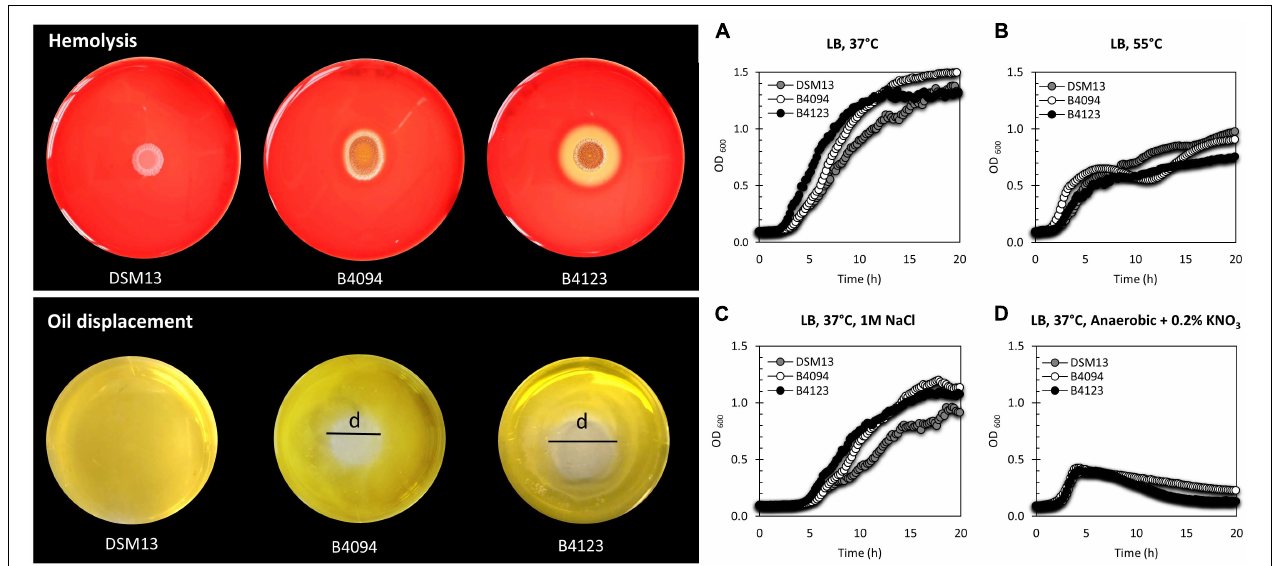
FIGURE 2 | Hemolysis, oil displacement, and representative growth data for the three selected strains, B4094, B4123, and DSM13 T . (Top left) DSM13 T , B4094, and B4123 growth on Columbia blood agar showing hemolytic activity. The clearing zone on the blood agar indicates results from lysis of erythrocytes, indicative of the presence of the biosurfactant lichenysin. (Bottom left) The oil displacement activity of DSM13 T , B4094, and B4123. The displacement zone (d) shows the oil-repelling movement away from water, indicative of the presence of a surfactant. (Right) Aerobic and anaerobic growth data for DSM13 T (gray), B4094 (white), and B4123 (black) in LB medium. (A) Growth in LB at 37 ◦ C; (B) Growth in LB at 55 ◦ C; (C) Growth in LB + 1M NaCl at 37 ◦ C; (D) Anaerobic growth in LB + 0.2% KNO 3 at 37 ◦ C.